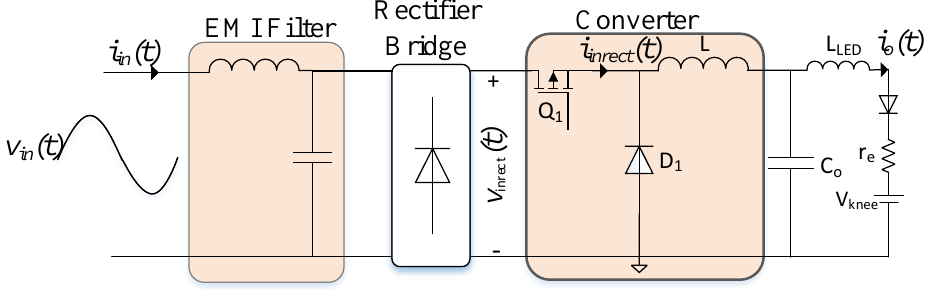
Figure 3. AC-DC E-Cap-less buck converter.